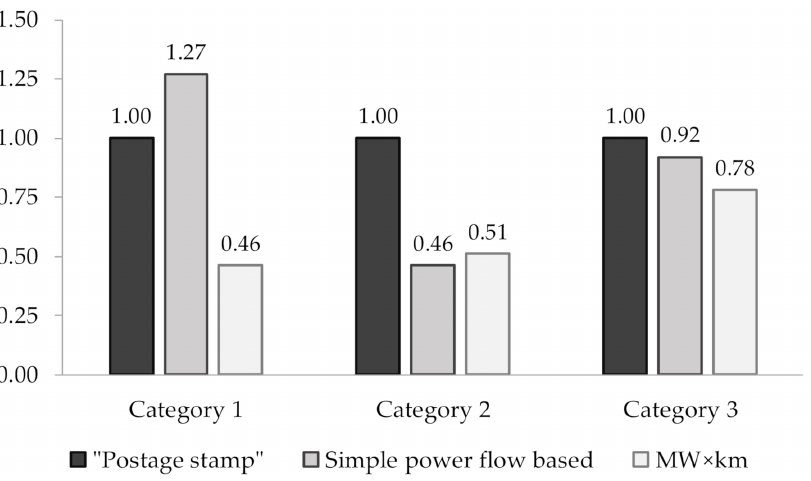
Figure 10. The relative rates of transmission charges for industrial customers of different